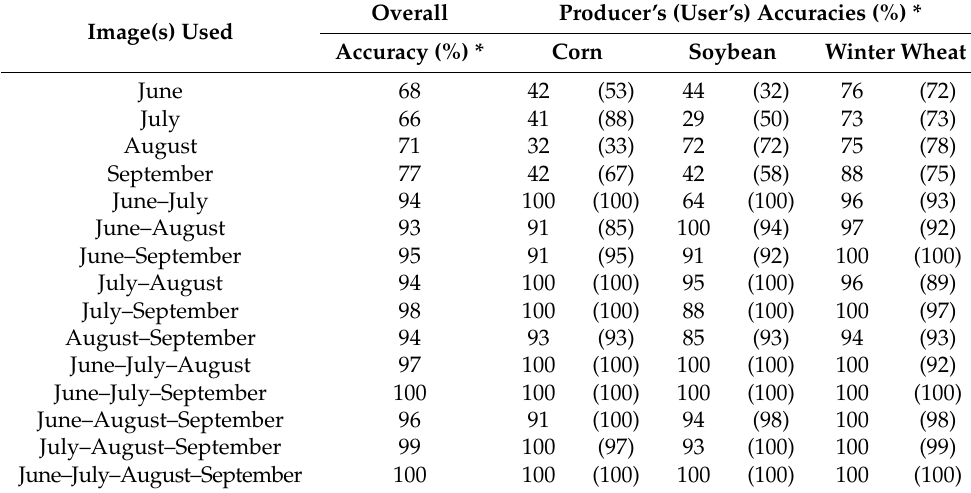
Table 6. Hyperion Random Forest Accuracies. Classification accuracies for Random Forest separating three leading world crops (corn, soybean, and winter wheat) using 15 Hyperion narrowbands. Analysis was conducted across 3 years, for 4 months throughout each growing season when available; these accuracies are averages across those 3 years.